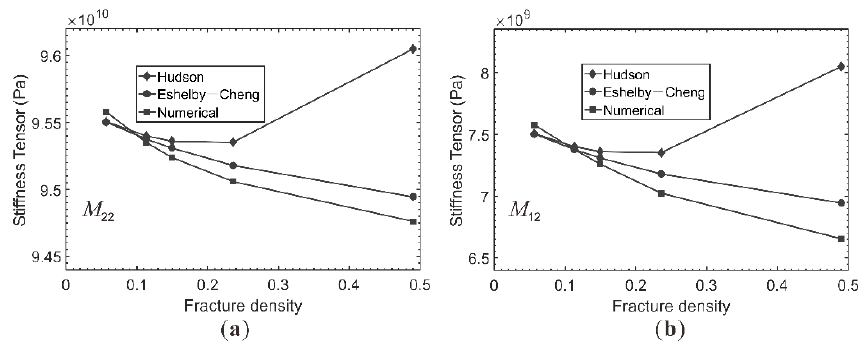
Figure 7. Comparison of numerical simulations and theoretical predictions for effective stiffness constants M 22 ( a ) and M 12 ( b ) for an isotropic background medium containing fractures saturated with brine.